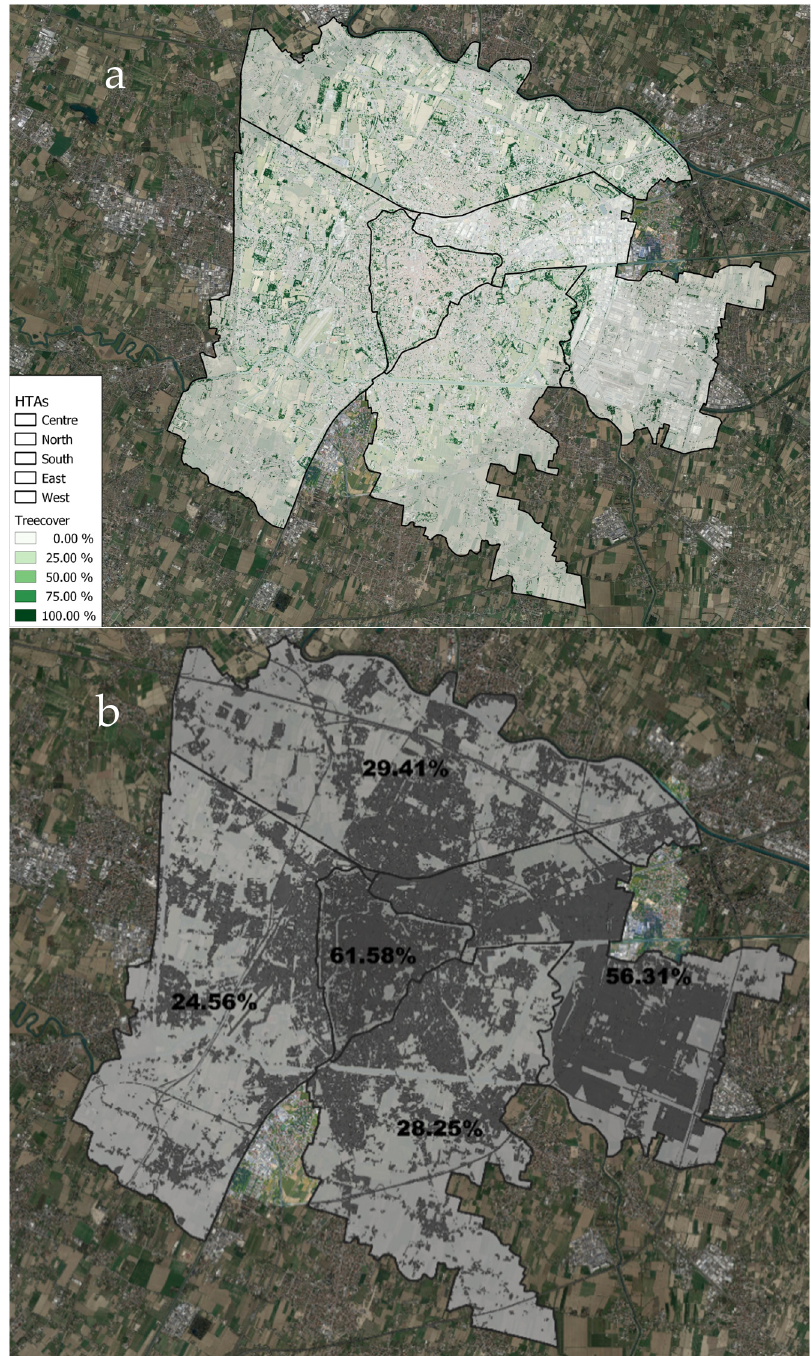
Figure 3. Tree cover map ( a ) and map of the permeability of soils ( b ) with the percentage of the impervious surfaces (highlighted in a darker colour) in the five homogeneous territorial areas (HTAs) of the Municipality of Padova.